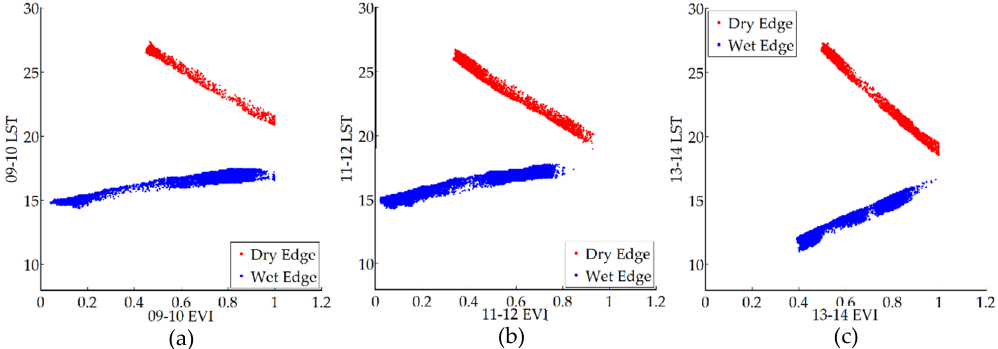
Figure 9. Regression of dry and wet edges estimated from STAEFM TIR on 18 January 2019 at ( a ) 09:00–10:00, ( b ) 11:00–12:00, and ( c ) 13:00–14:00. Table 4. Slope and offset of dry and wet edges estimated from STAEFM TIR on 18 January 2019. EVI, enhanced vegetation index.